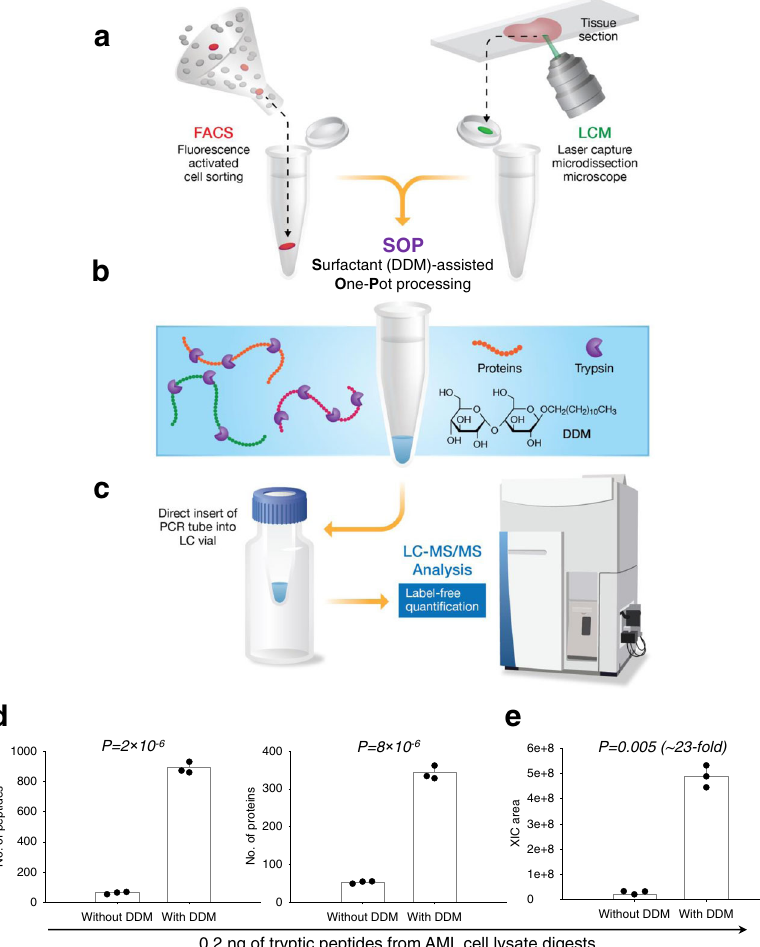
Fig. 1 Schematic diagram of the SOP-MS work fl ow. a Single cells or small numbers of cells are sorted either by fl uorescence-activated cell sorting (FACS) or laser capture microdissection (LCM) and collected into single PCR tube or a 96-well PCR plate. After FACS isolation, the sorted cells are subjected to centrifugation at 1000 g for 10 min to ensure them at the bottom of the PCR tube or 96-well PCR plate. For LCM, the dissected tissue voxels are catapulted into a 5 µ L water droplet on the PCR tube cap, followed by centrifugation at 1000 g for 10 min. b For cell lysis, a cell lysis buffer containing 0.2% (w/v) n- Dodecyl β -D-maltoside (DDM) is added to the PCR tube or 96-well PCR plate followed by incubation at 75 °C for 1 h. Sample is subjected to reduction and alkylation (these two steps are optional). Small amounts of trypsin are used for overnight digestion: 2 ng for single cells and 5 ng for 10 – 100 cells, and the fi nal DDM concentration is ~0.015%. c Prior to LC-MS analysis, the cap of the PCR tube is removed and the tube is inserted into a sample vial to avoid transfer loss. The 96-well cap matt is used to cover the 96-well plate for automatic injection without sample transfer. Samples are analyzed by standard LC-MS platforms for quantitative proteomic analysis. The freely available open-source MaxQuant software is used for label-free quanti fi cation. d Number of unique peptides and protein groups identi fi ed by MS/MS only for 0.2 ng of tryptic peptides from AML cell lysate digests (three biological replicates per condition) without and with 0.015% DDM ( P < 0.05 between without and with DDM). e The total extracted ion chromatogram (XIC) peak area for 0.2 ng of AML cell lysate digests (three biological replicates per condition) without and with 0.015% DDM ( P < 0.05 between without and with